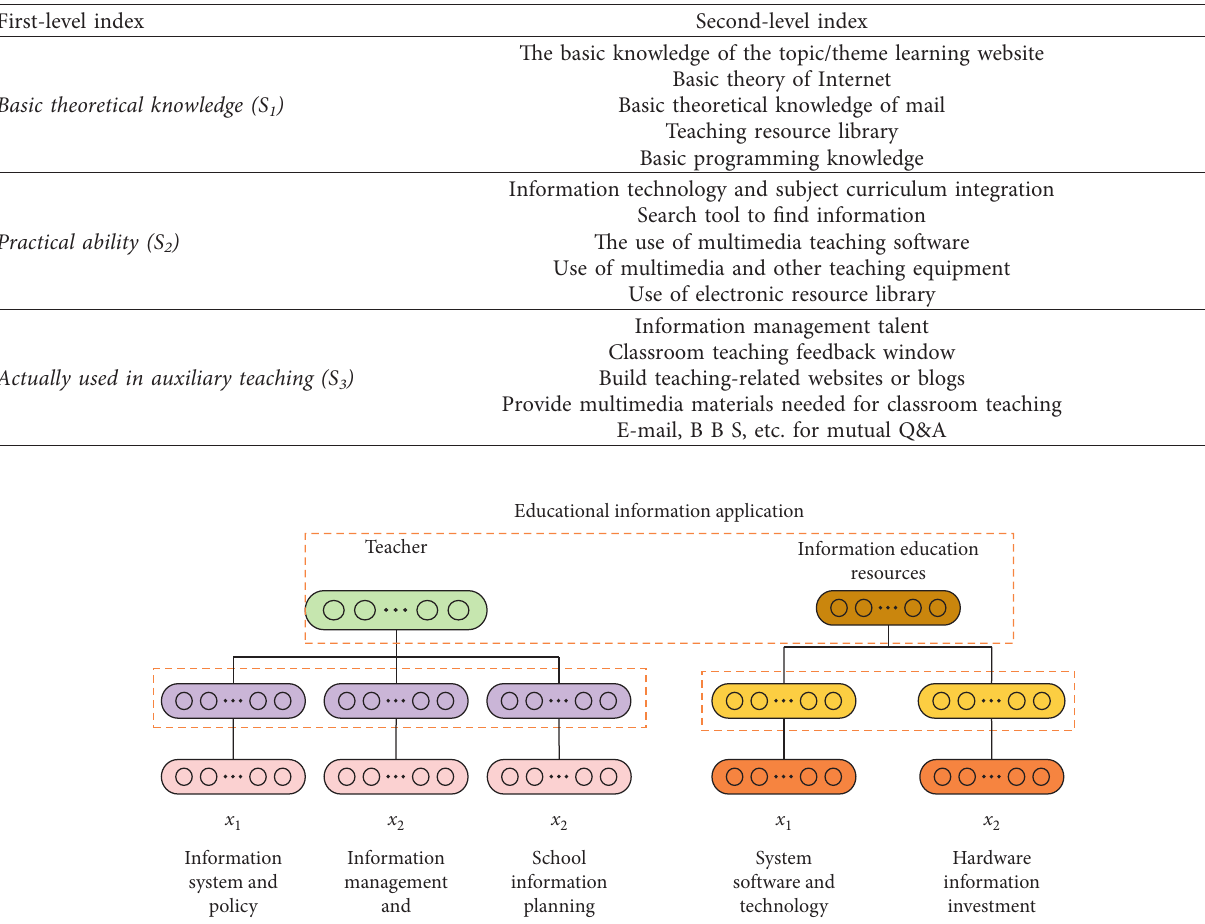
Table 1: Evaluation index system of informatization level.